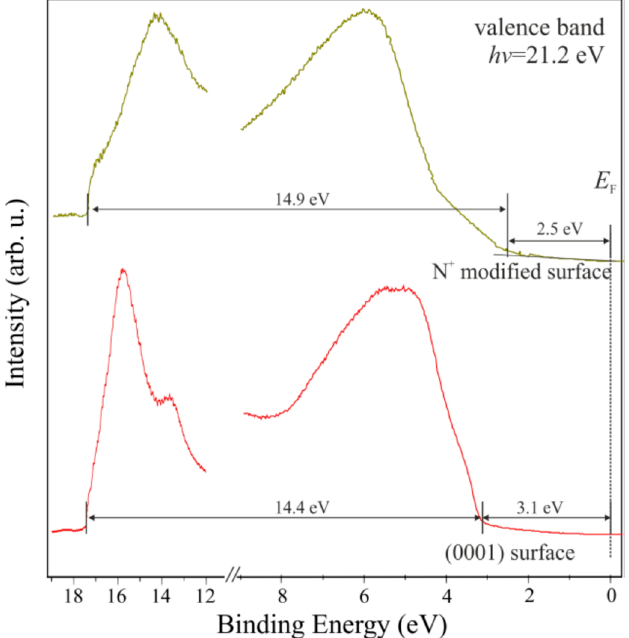
Figure 9. UPS spectrum for n ‐ GaN(0001) before and after bombardment with N ions. Reprinted with permission from [73]. Copyright Acta Phys. Pol. A.